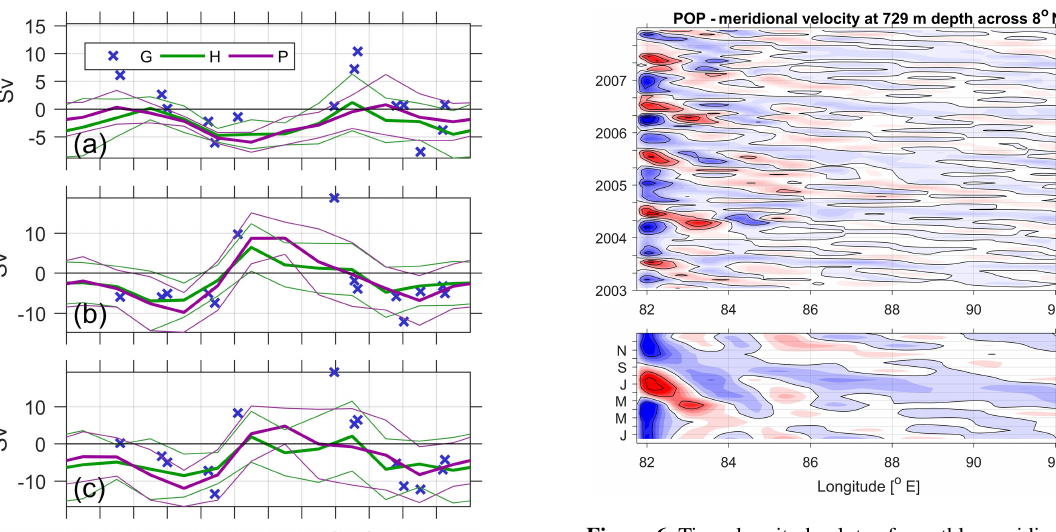
Figure 6. Time–longitude plots of monthly meridional velocity (a) and seasonal mean velocity (b) over 2003–2007 across 8 ◦ N at 729m from POP. Note the difference in color scale. from 1 to 6 Sv into and out of the BoB (Fig. 5a).